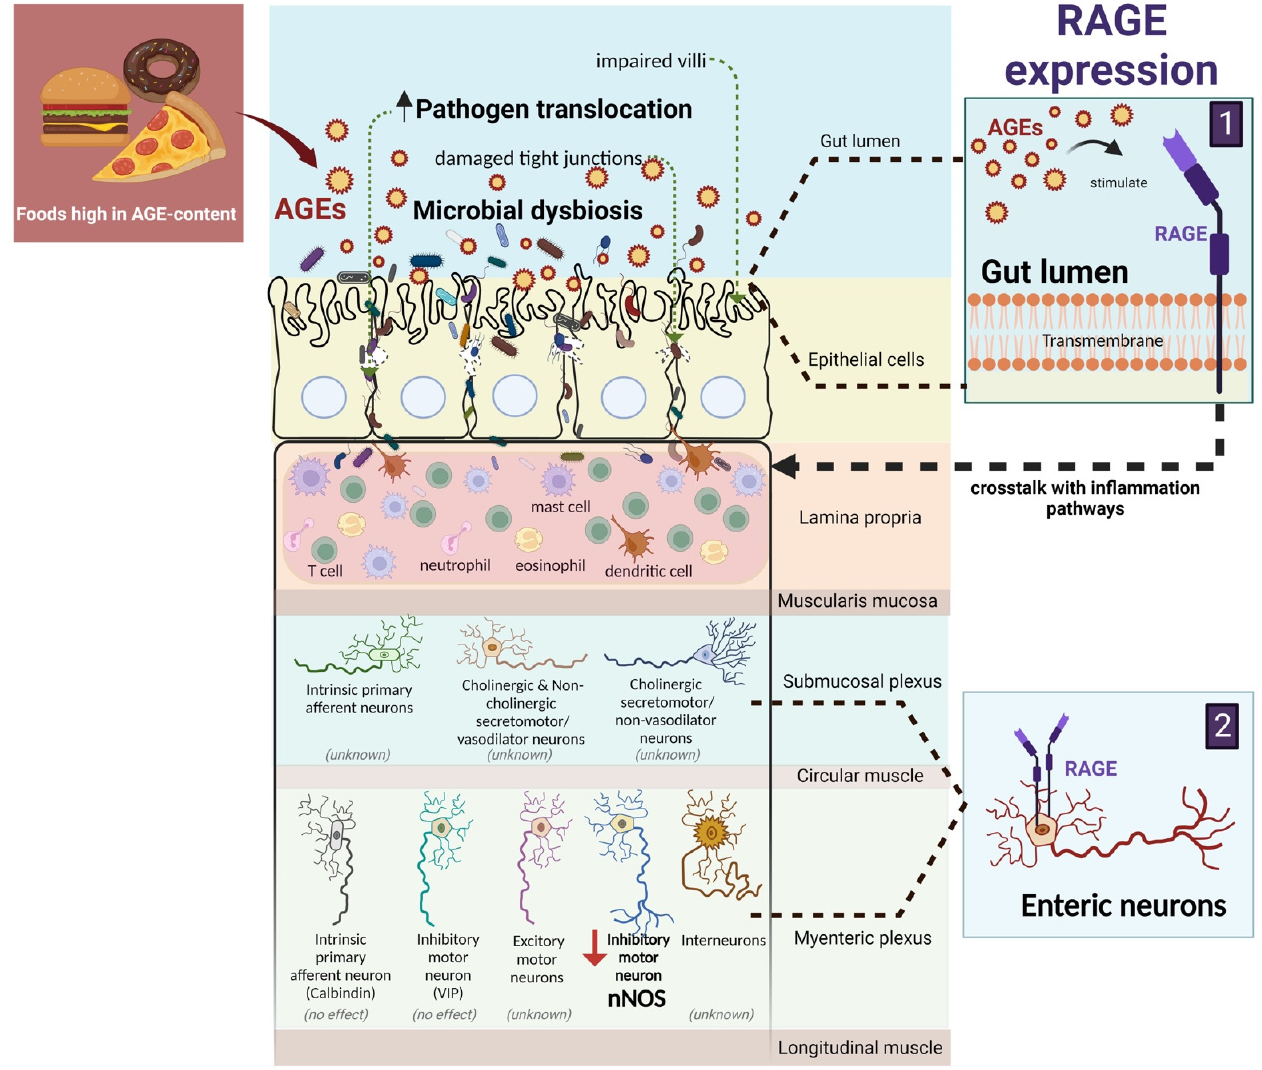
Figure 2. Overview of the effects of dietary AGEs on the gut. AGEs are ligands for various cell surface receptors, of which the receptor for AGEs (RAGE) is the main one and has been extensively studied. RAGE is expressed in the intestinal epithelium and the enteric neurons of the submucosal plexus and myenteric plexus. There has been growing interest indicating the potential roles of endogenous and exogenous AGEs that may act synergistically to accelerate the pathogenetic effects associated with AGEs. AN excessive dietary AGE intake is associated with alterations in the gut structure leading to enhanced gut barrier dysfunction, changes in the expression of enteric neurons, microbial dysbiosis, and inflammation (Created with BioRender.com).